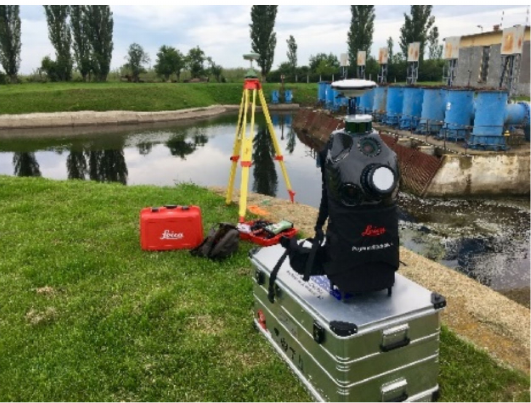
Figure 6. Rinex data collection at one second ( Pumping Station, Cruceni, Romania).